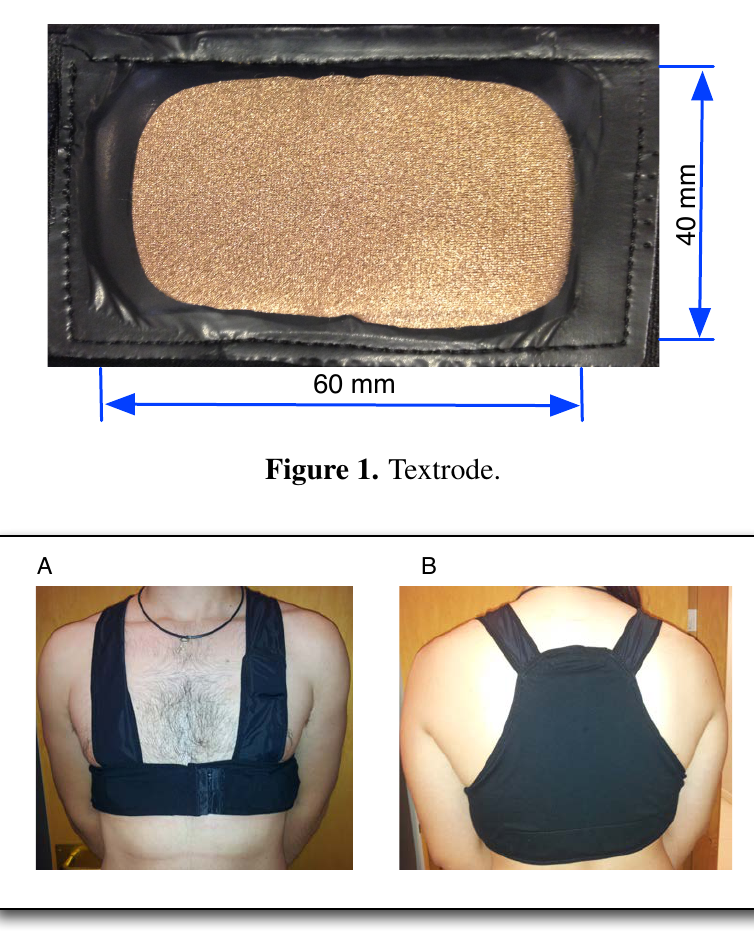
Figure 2. Vest: ( A ) front view; ( B ) back